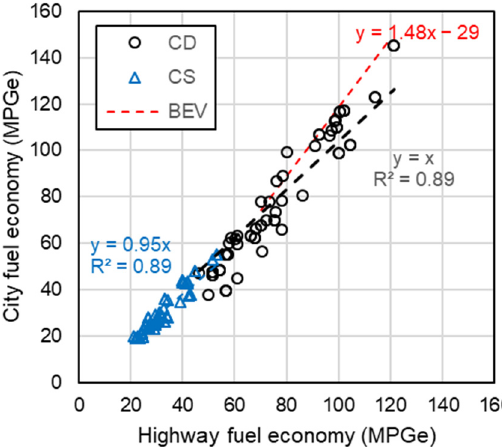
Figure 4. Correlation between EPA city mileage and EPA highway mileage for light duty PHEVs.